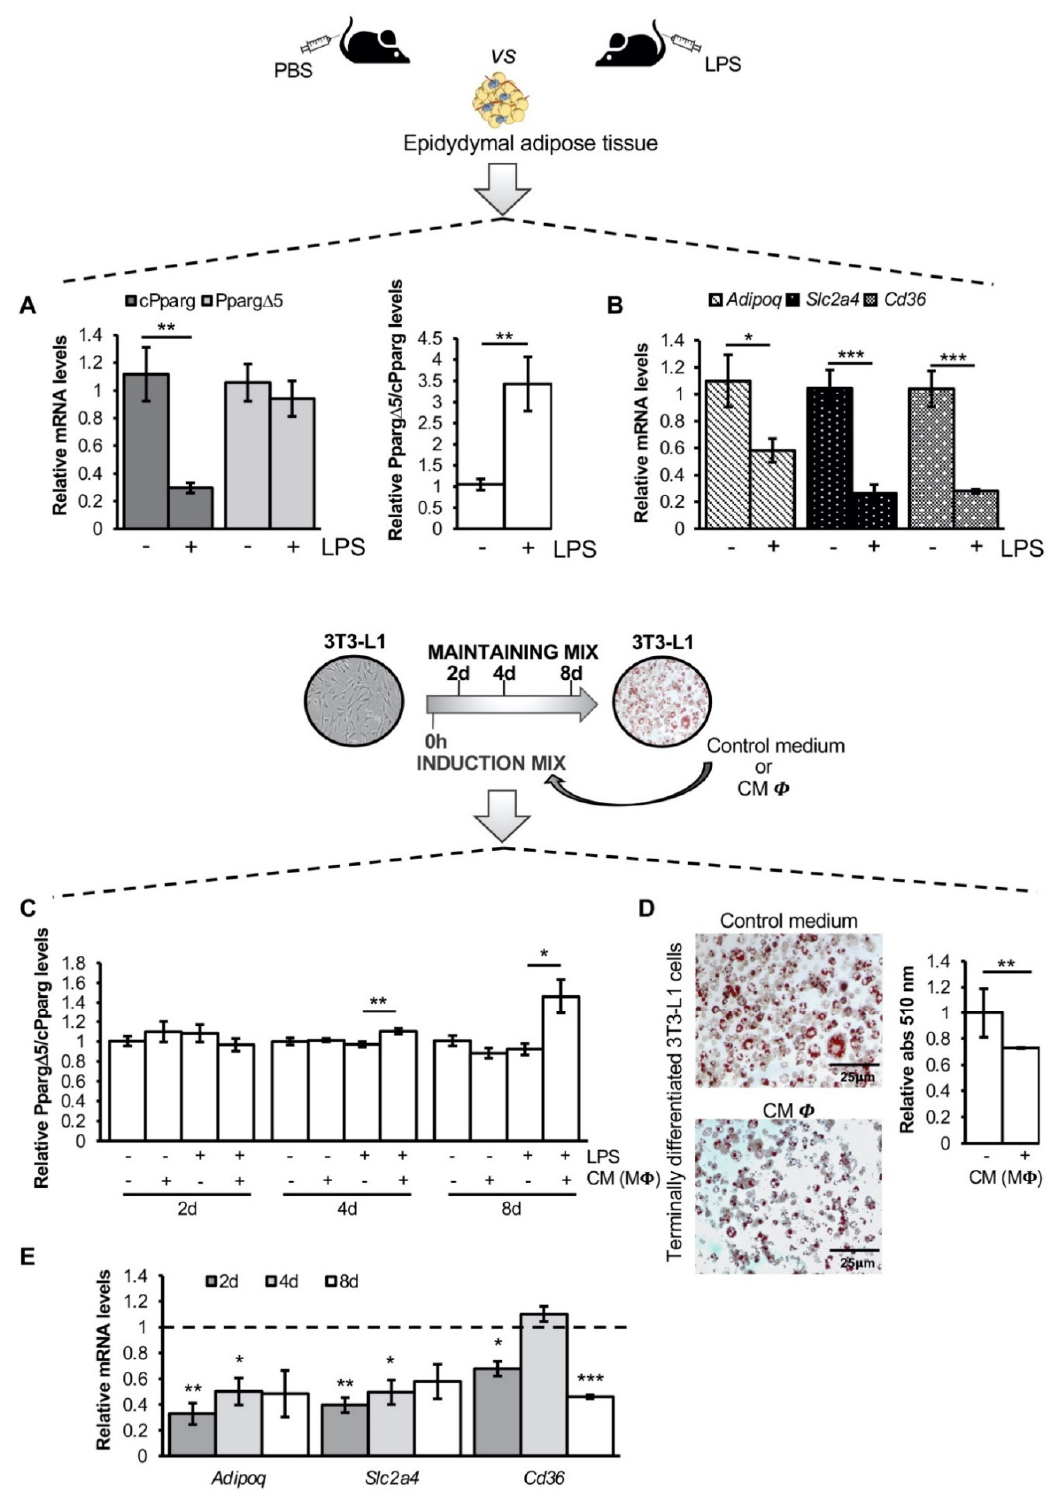
Figure 1. Inflammation affects Pparg expression and splicing in vitro and in vivo: ( A ) Relative mRNA quantification (qPCR) of canonical Pparg transcripts (cPparg), Pparg ∆ 5 (left panel), Pparg ∆ 5/cPparg ratio (right panel) and Ppar γ target genes (i.e., Adipoq , Slc2a4 and Cd36 , ( B )) in epididymal